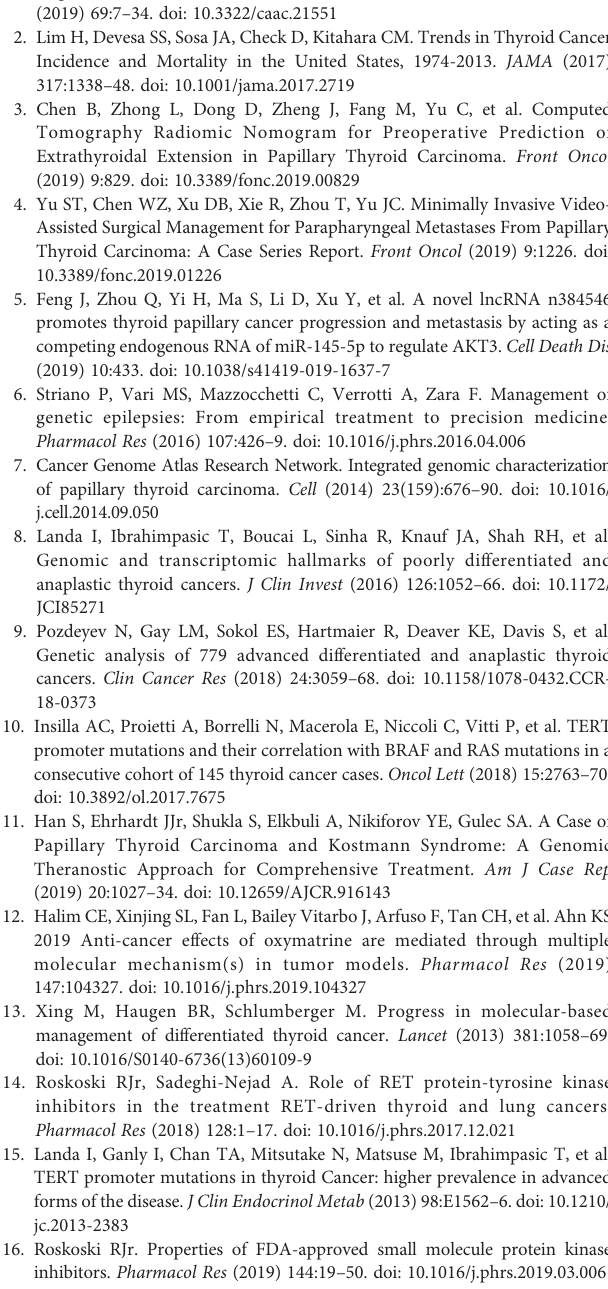
SUPPLEMENTARY TABLE 1 | Search strategies. SUPPLEMENTARY TABLE 2 | Quality assessment of included of studies by Critical Appraisal Skills Programme (CASP) scales. SUPPLEMENTARY TABLE 3 | Assessment of the quality of evidence using the Grading of Recommendations